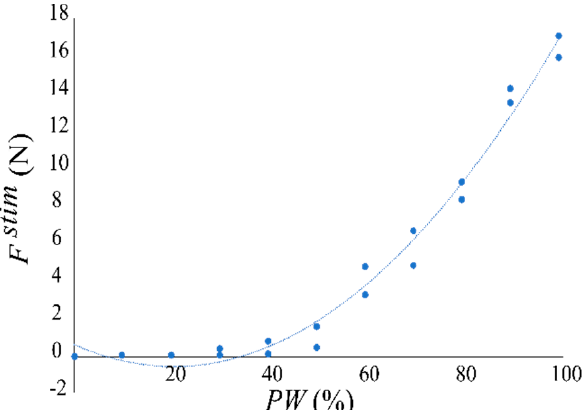
Figure 3. Interpolation of the calibration results relative to the stimulation provided on the biceps muscle for a sample subject. On the x -axis, the PW values given to the subject via the NMES system are represented. On the y -axis, the muscle response with respect to the force measured by the force sensor is depicted. PW range is between 1 and 60 μ s, normalized in percentage with an interval of 10% between each delivered stimulus.